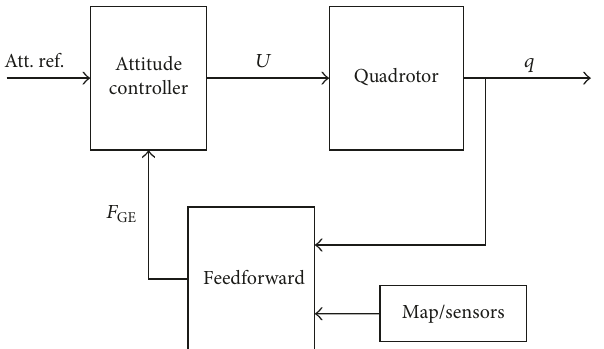
Figure 19: Control scheme of feedforward controller.